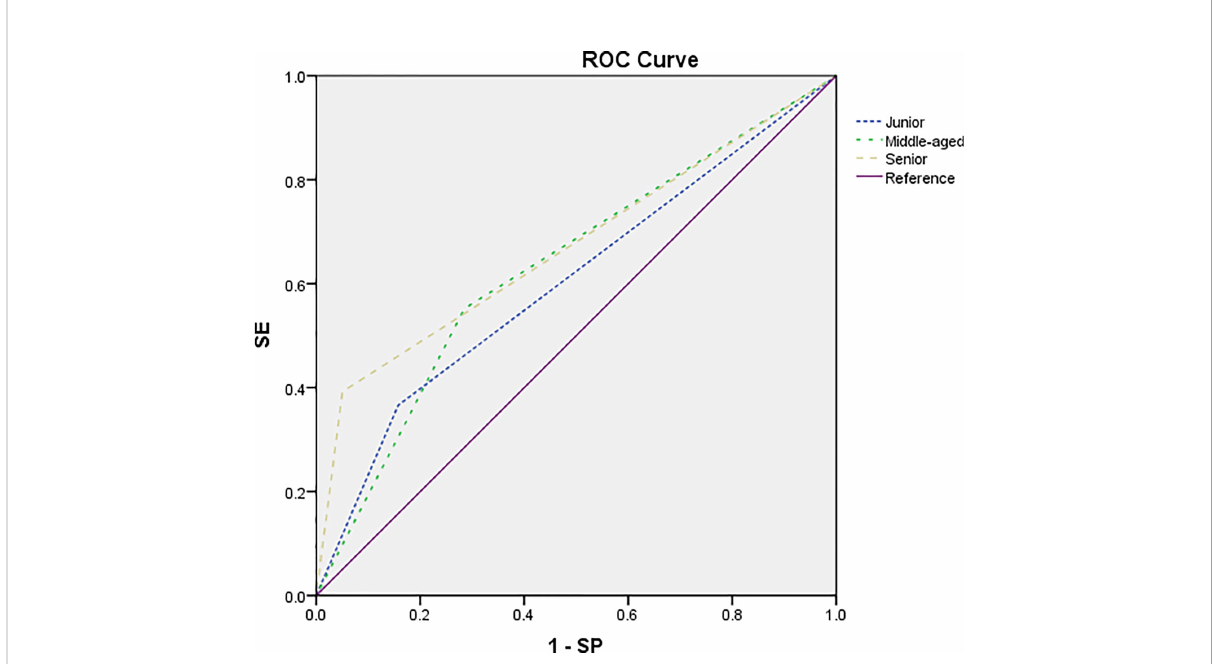
FIGURE 7 The ROC curve of the subjective diagnosis on nodes by a junior radiologist (short dotted line), a middle-aged radiologist (midpoint dotted line), and a senior radiologist (long dotted line). The AUC was estimated to be 0.604, 0.634, and 0.671,